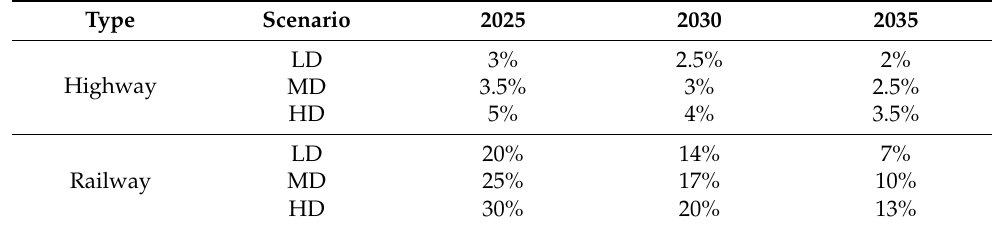
Table 4. Growth rate of highway and railway mileage in Shandong Province from 2020 to 2035.